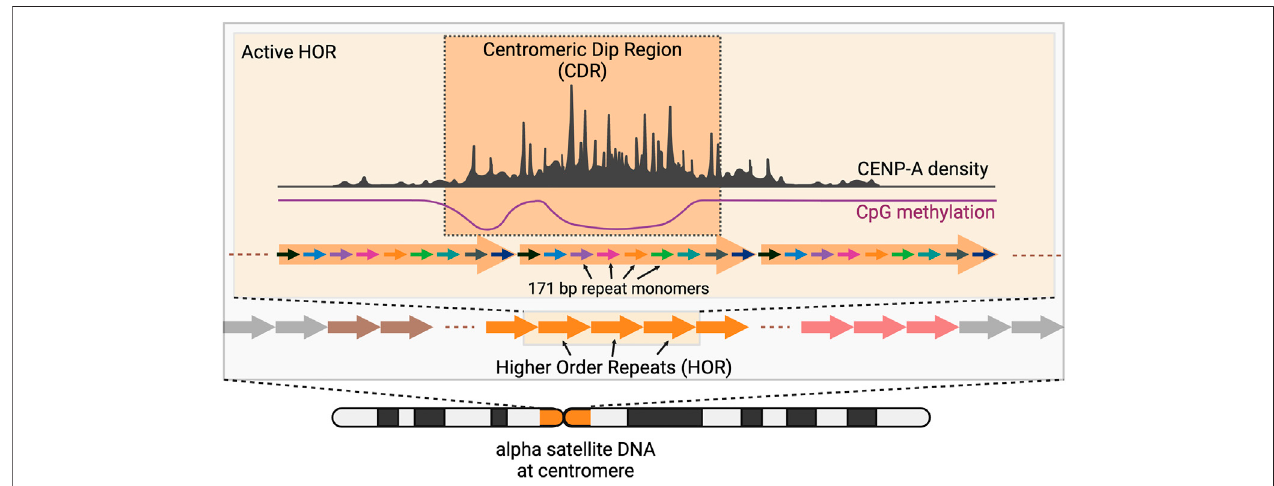
FIGURE 1 | Centromeres contain arrays of higher order repeats (HORs) made of ~171 bp alpha satellite repeat monomers. CENP-A nucleosomes are organized within the “ active ” HOR of the chromosome and are found enriched at the region of low local CpG methylation also known as Centromeric Dip Region or CDR. (Created with